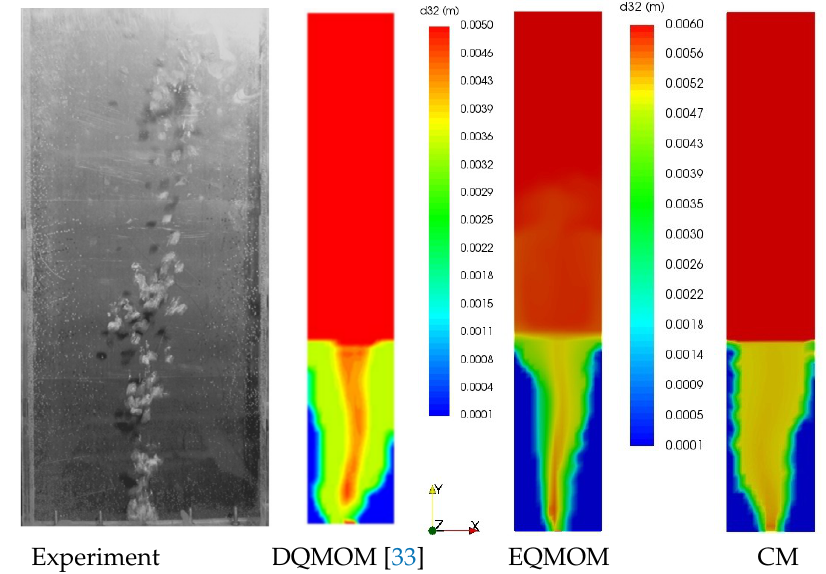
Figure 3. Experimental snapshot of a meandering bubble plume by Buwa et al. [63] and the predicted Sauter mean diameter using DQMOM ([33]), EQMOM and